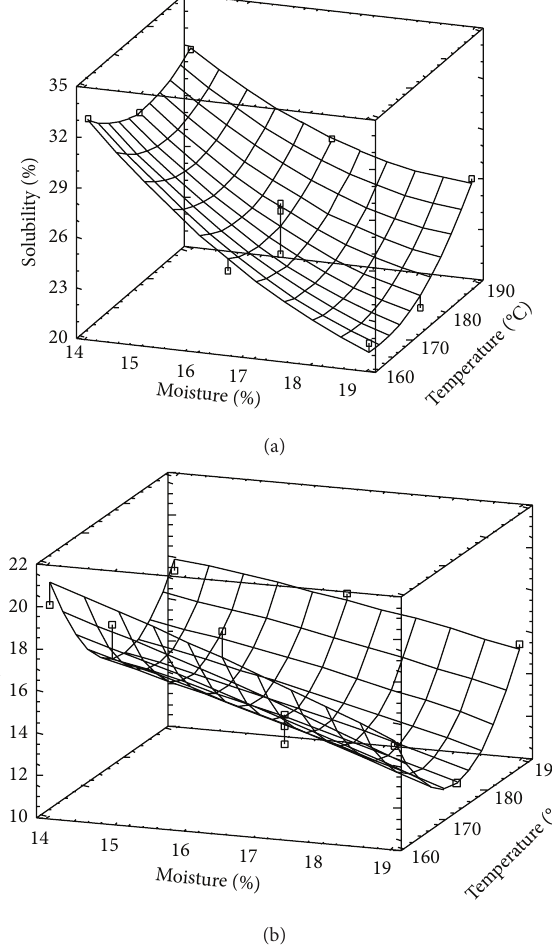
Figure 5: Surface response for solubility corresponding to Fortuna rice (a) and Paso 144 rice variety